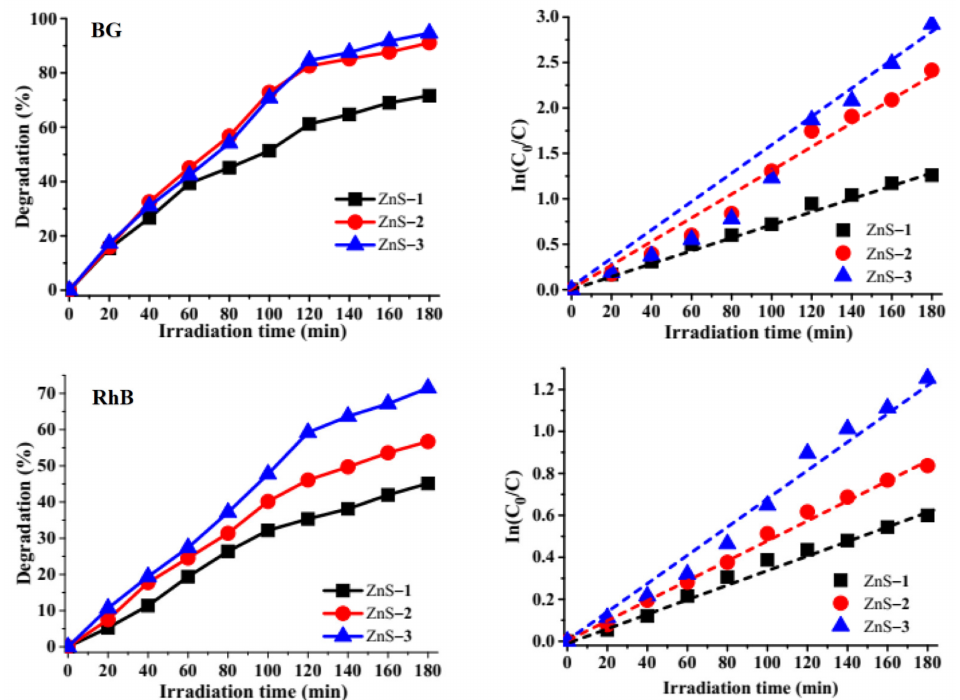
Figure 5. Degradation efficiency curves of brilliant green (BG) and rhodamine B (RhB) by ZnS quantum dots and their corresponding kinetics studies